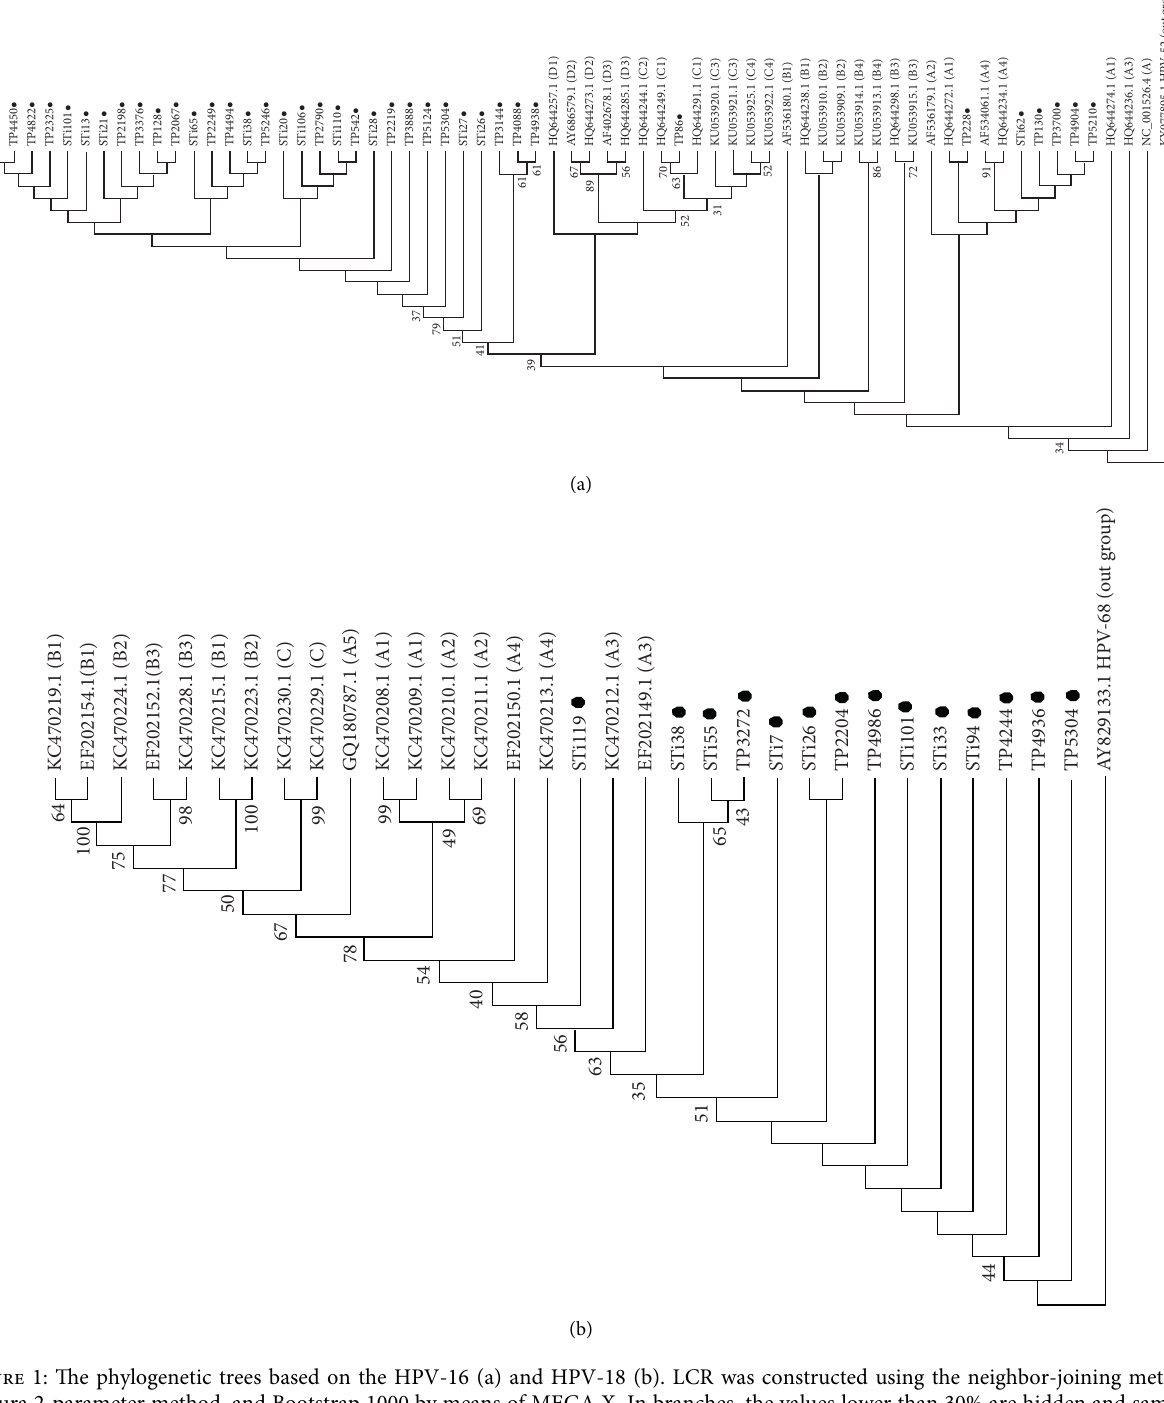
Figure 1: The phylogenetic trees based on the HPV-16 (a) and HPV-18 (b). LCR was constructed using the neighbor-joining method, Kimura 2-parameter method, and Bootstrap 1000 by means of MEGA X. In branches, the values lower than 30% are hidden and samples with small black circles were understudied. HPV-16 and-18 LCR partial sequences of Iranian isolates obtained from this study were recorded in GenBank with accession numbers KF447488-KF447525 and MZ868727-MZ868740,